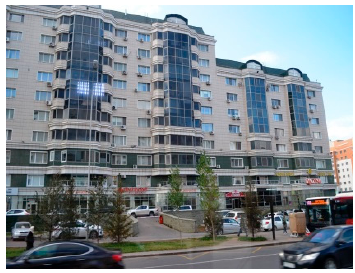
Figure 5. Premium class building.